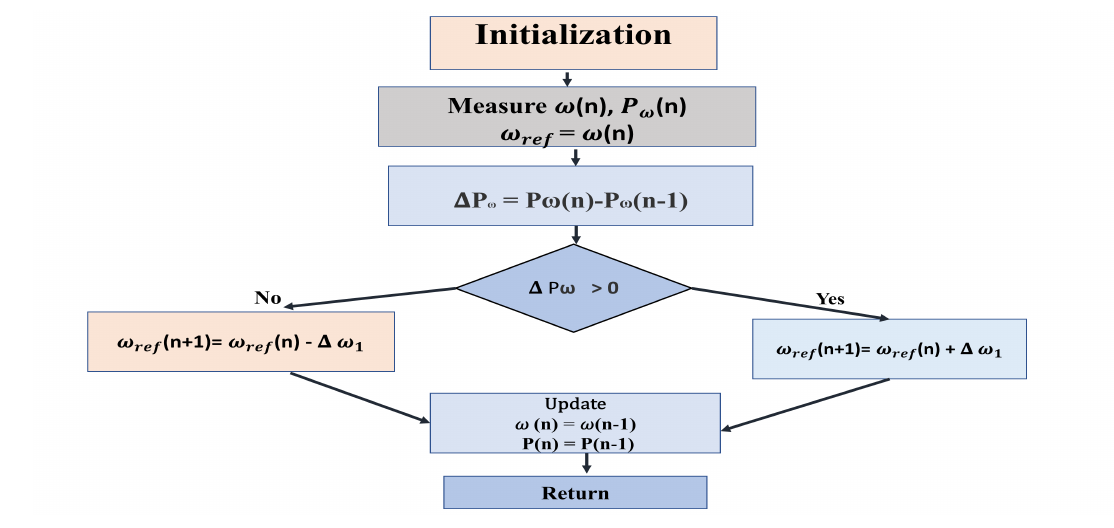
Figure 10. Flowchart of CPO algorithm.